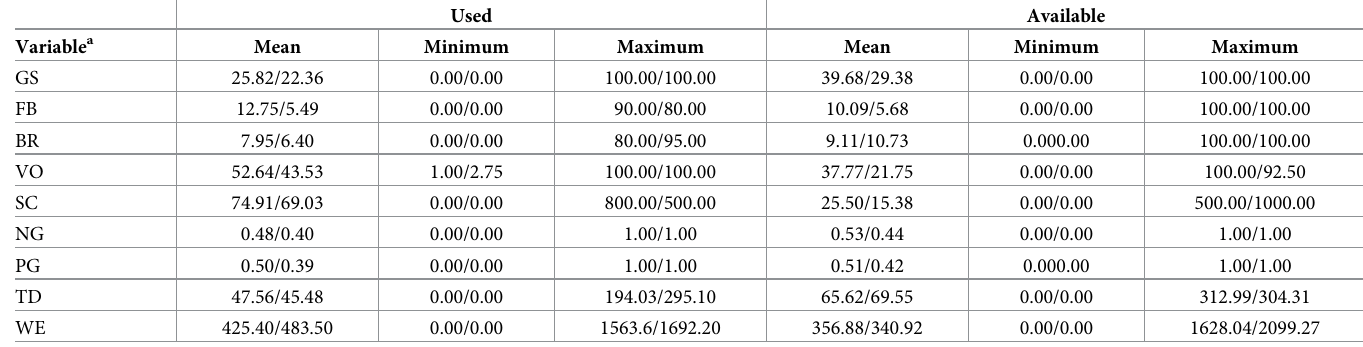
Table 1. Minimum, mean, and maximum for all covariates used in discrete choice resource selection models for Northern bobwhite during fall (Nov) and winter (Dec–Jan; fall/winter) in southwest Missouri, 2018–2019. Used Available Variable